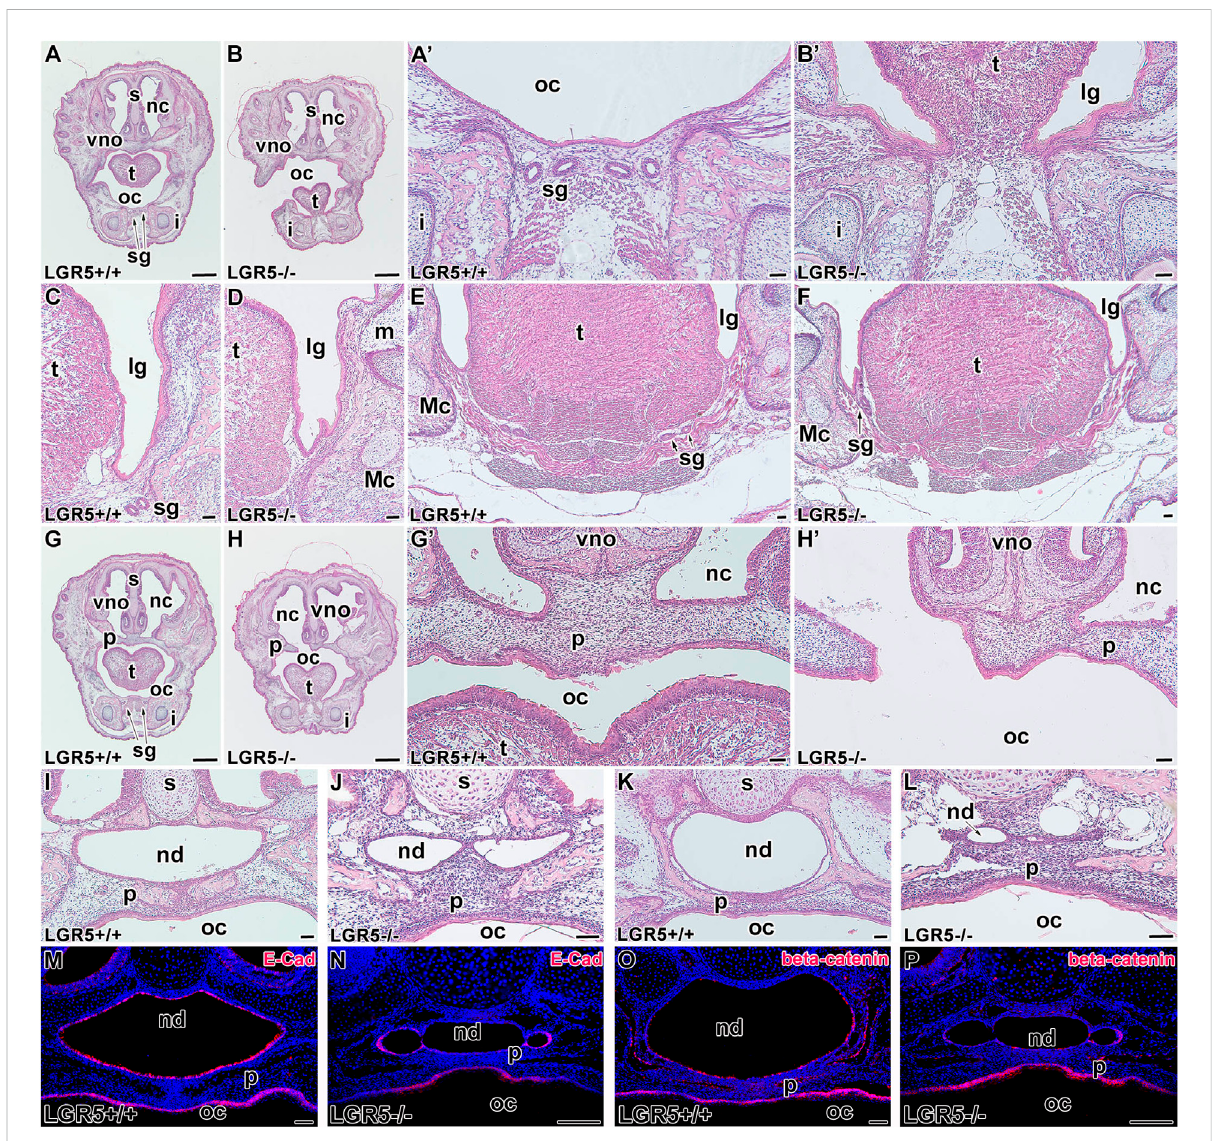
FIGURE 11 Craniofacial abnormalities of Lgr5 − / − mice at E18.5. Lgr5 − / − mice exhibit several craniofacial abnormalities also later in development at E18.5 (A-L) . Low-magni fi cation images of transversal section through rostral area of the head in Lgr5 +/+ (A) and Lgr5 − / − (B) mice stained by Hematoxylin-Eosin. Higher-magni fi cation images of tongue area in WT embryo (A´) without abnormalities and Lgr5 -de fi cient embryo with ankyloglossia (B´) . While there is not any defect in the area of lingual groove of WT embryo (C,E) , Lgr5 -de fi cient mice exhibit noticeable epithelialbranchingandfoldingintheareaoflingualgroove (D) .Salivaryglandsarelocatedinmorecaudalpartin Lgr5 − / − animals (F) incomparisonto Lgr5 +/+ embryos (E) .Lowmagni fi cation (G) andhighmagni fi cation (G´) imageofdeveloping palate. In Lgr5 -de fi cient mice,there isthecleft palate in low-magni fi cation (H) as well as high-magni fi cation (H´) images. (J) The histological sections of Lgr5 +/+ nasopharyngeal duct (I) and Lgr5 − / − nasopharyngeal duct with distinct midline epithelial bridge. Caudal area of nasopharyngeal duct of WT embryo (K) and mutant embryo with distinct abnormalities such as an epithelial fusion of nasopharyngeal duct (L) . There is downregulation of E-cadherin expression mutant mice (N) in comparison to WT (M) . Also β -catenin expressionisdecreased in Lgr5 +/+ (O) and Lgr5 − / − (P) mice. i,incisor; lg, lingual groove; m,molar;Mc,Meckel ’ s cartilage; nc, nasal cavity; nd, nasopharyngeal duct; oc, oral cavity; p, palate; s, septum; sg, salivary gland, t. tongue; vno, vomeronasal organ. Scale bars for A, B. G, H μ 1 mm. Scale bars for others = 100 μ